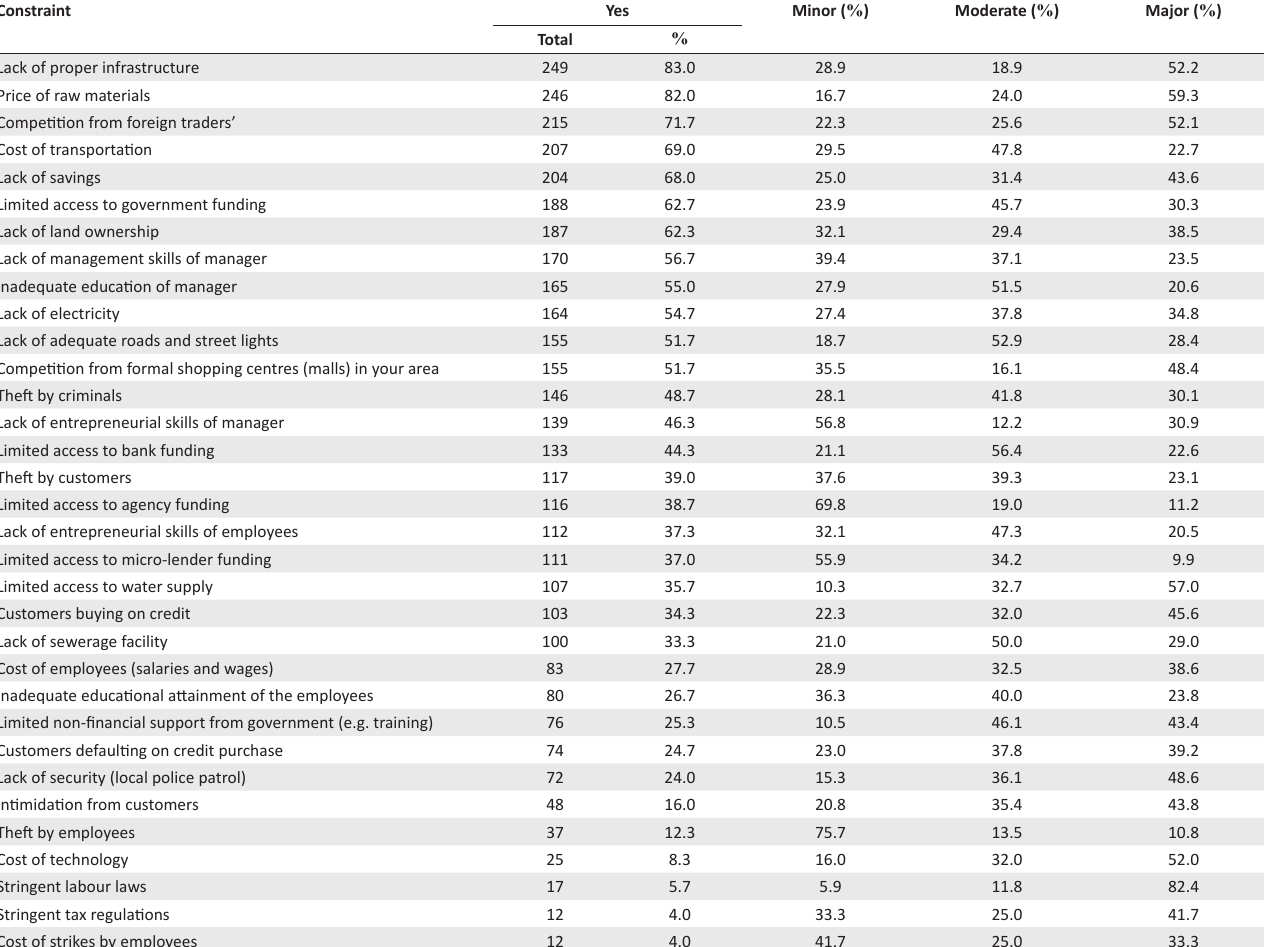
TABLE 5: Matrix of internal enterprise growth constraints ( n = 300).